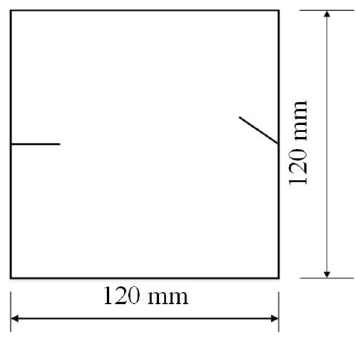
Figure 42. Specimen with two 20 mm long